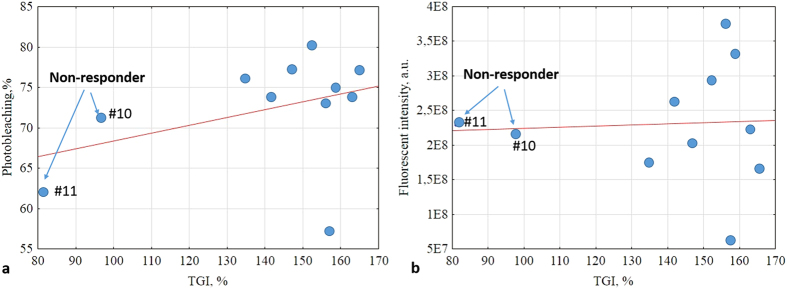
(a) Relationship between photosensitizer photobleaching (Equation (1)) and tumour volume quantified by TGI (Equation (2)). A weak correlation is seen (Pearson’s correlation coefficient r = 0.386, p = 0.241). (b) Fluorescence intensity versus TGI. An even weaker correlation noted (r = 0.052, p = 0.879).